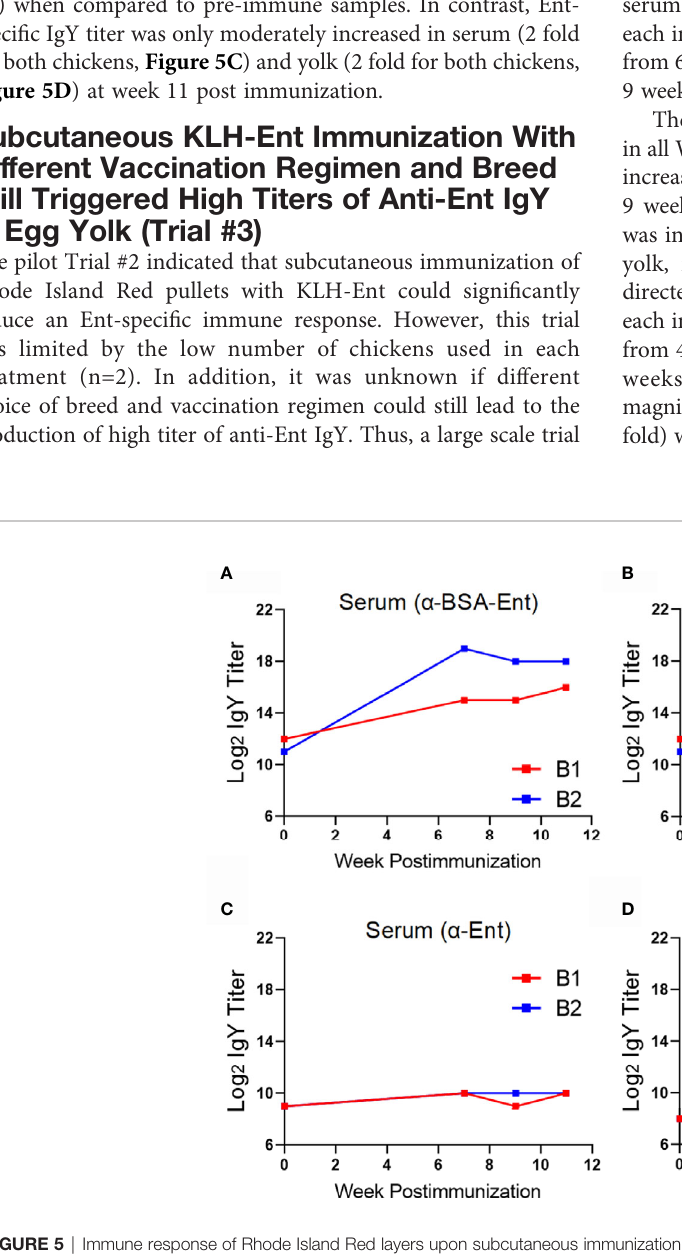
FIGURE 5 | Immune response of Rhode Island Red layers upon subcutaneous immunization with the BSA-Ent conjugate (Trial #2). (A) Serum IgY titer against the BSA-Ent conjugate. (B) Egg yolk IgY titer against the BSA-Ent conjugate. (C) Serum IgY titer against Ent molecule. (D) Egg yolk IgY titer against Ent molecule. Each point represents mean IgY titer from duplicate measurements within single chicken. B1 and B2 denote the two individual chickens immunized with